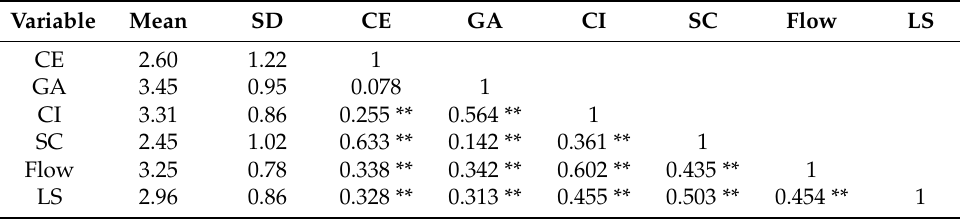
Table 4. Descriptive statistics and correlations between